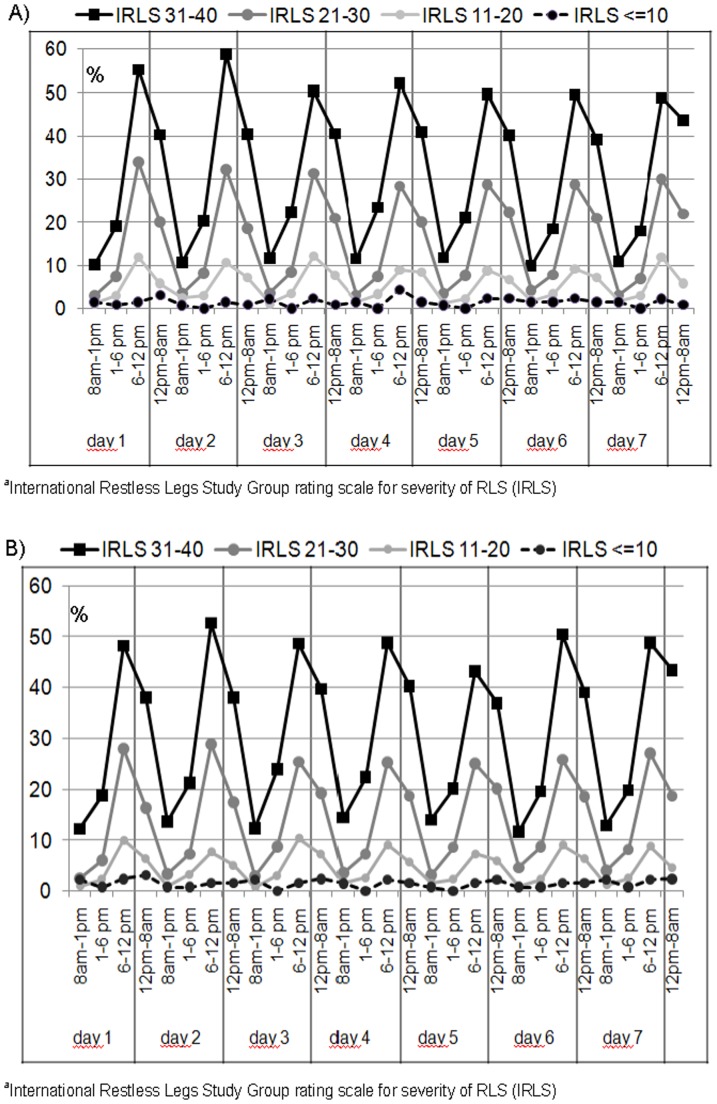
A) Short term variation of the RLS minimal criterion “urge to move” in the 7-day diary, according to IRLSa score and time of the day. B) Short term variation of the RLS minimal criterion “dysaesthesia” in the 7-day diary according IRLSa score and time of the day.